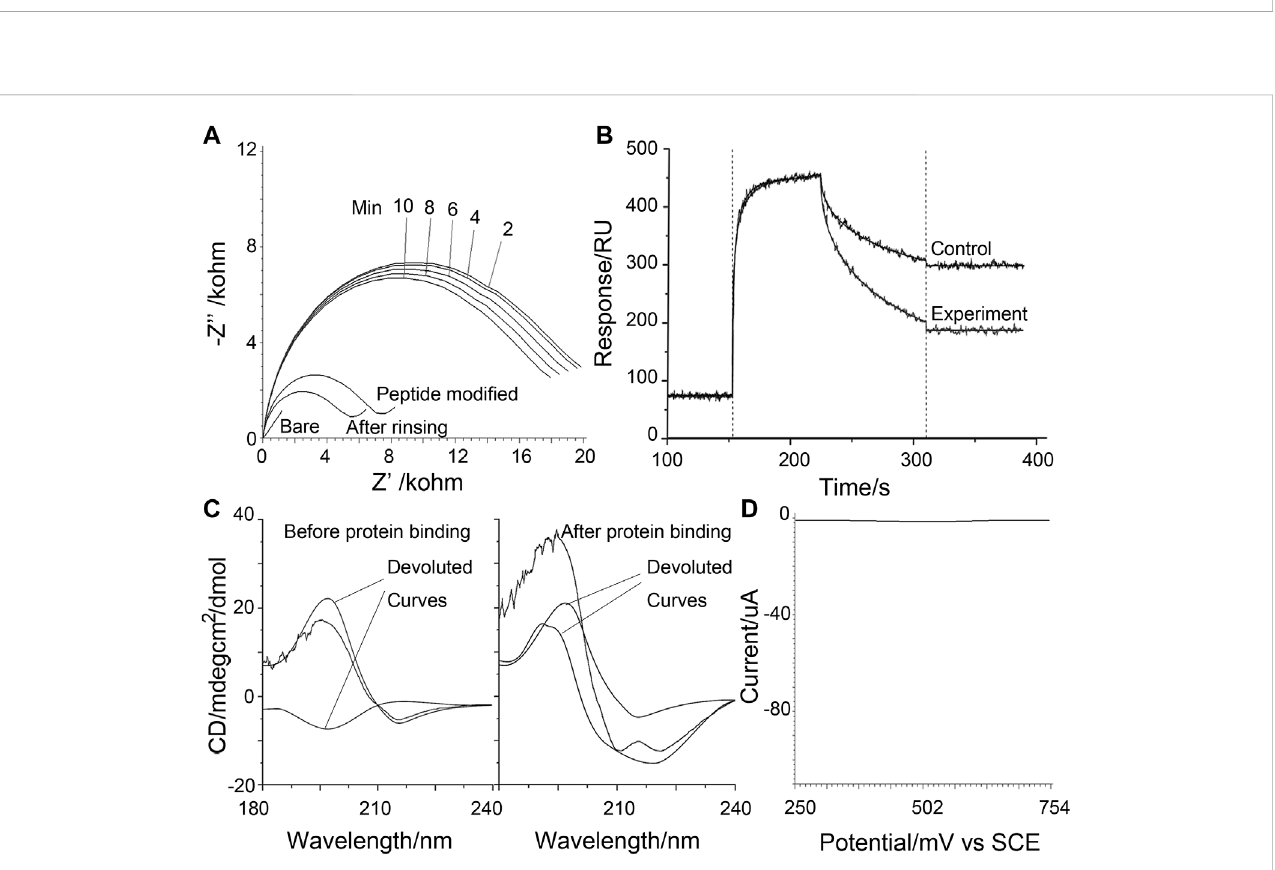
FIGURE 3 (A) Electrochemical impedance spectra recorded under various conditions as labeled on the graph. The time series indicates measurements after a graduallylongerdurationofelectrochemicalscanningtoagitatetheCuionfacilitatedreactions. (B) Surfaceplasmaresonancesensorgramcontractsthereal- time behavior of the self-cleavable probe with a control probe that cannot self-cleave. (C) Circular dichroism data was obtained for the control probe before and after protein binding-induced cross-linking. The experimental curve (black line) is de-convoluted to possible components. (D) Control square wave voltammograms of poly-tyrosine were obtained in detecting 10 nM MDM2 using a p53-derived alpha-helix forming peptide